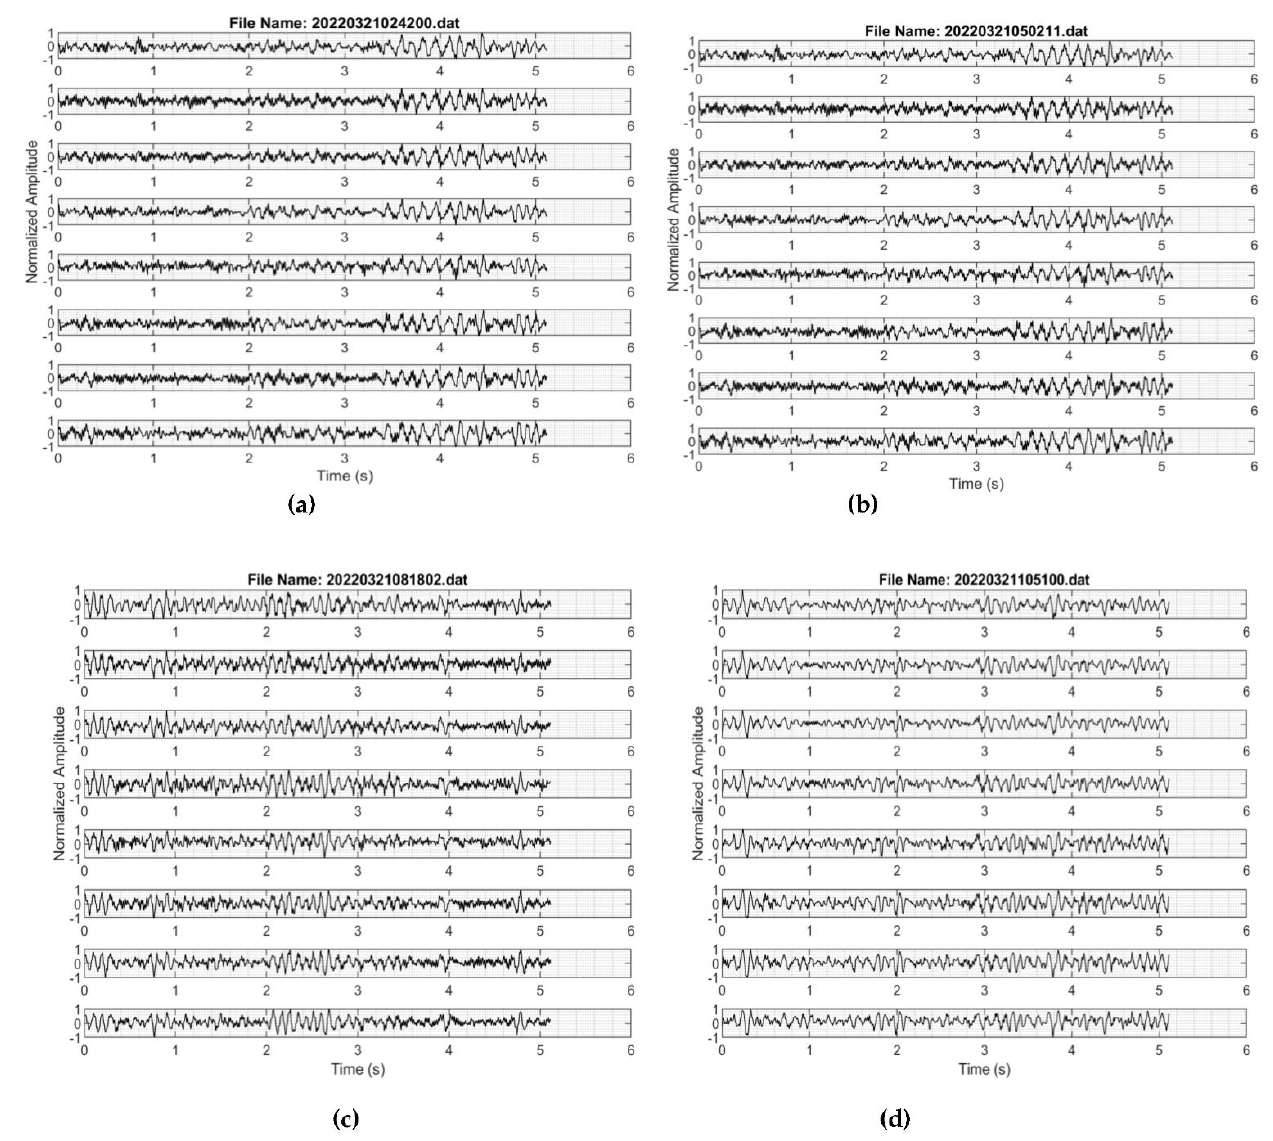
Figure 10. Screenshots from live streams of the seismic waveforms for the eight-channel seismo- graph running on the web browser of the Raspberry Pi. ( a ) Generated by banging. ( b ) A zoomed-in section of channel 1.